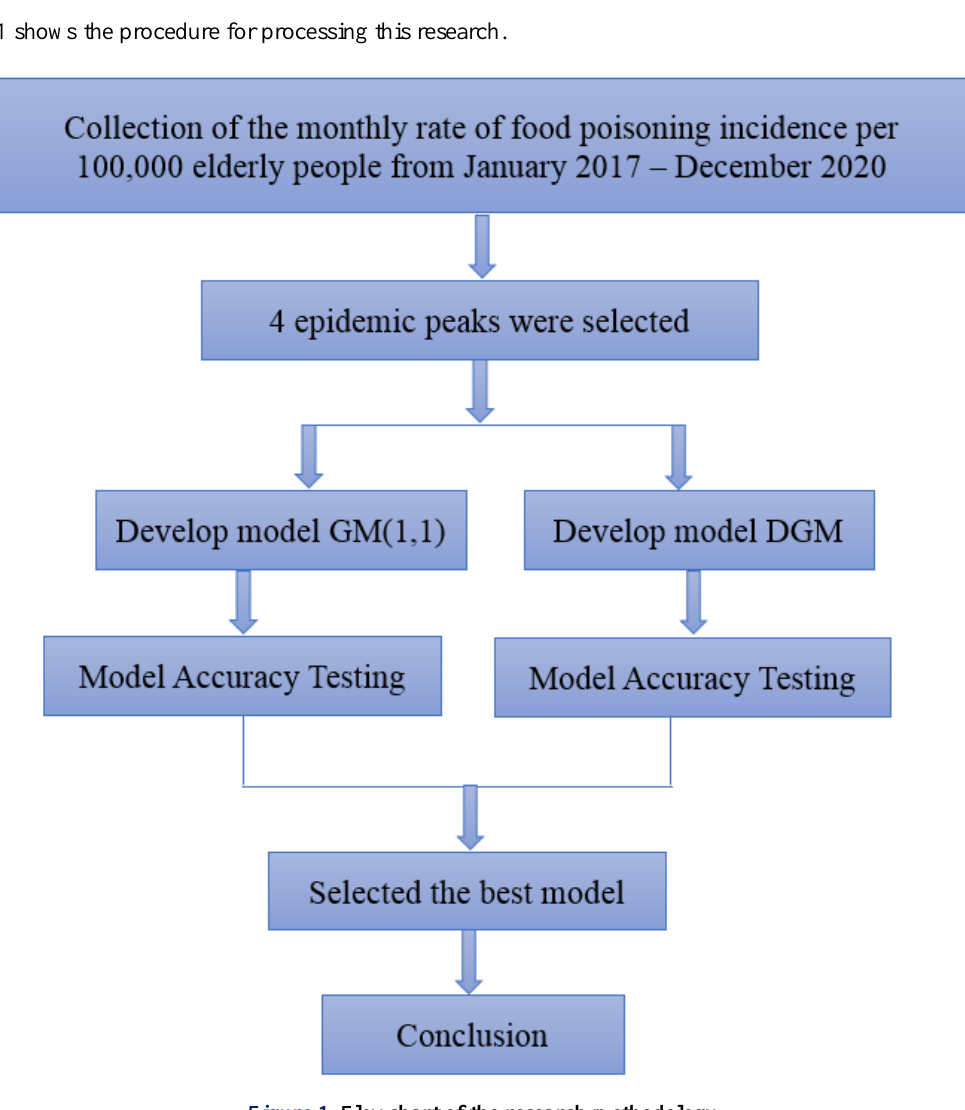
Figure 1. Flowchart of the research